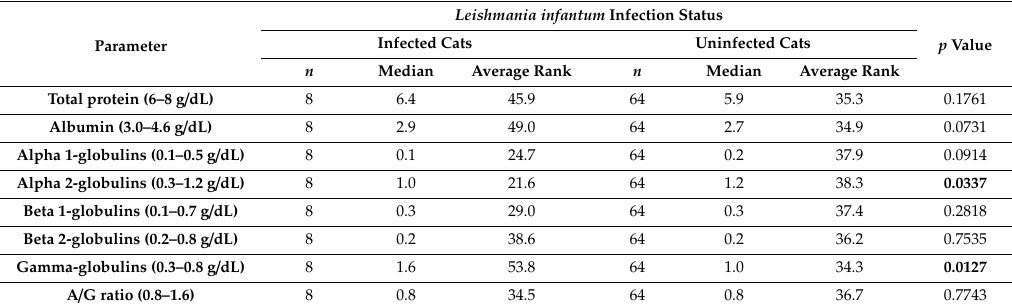
Table 7. Comparison of total protein, albumin, globulin content, and albumin to globulin ratio between L. infantum infected and uninfected cats.